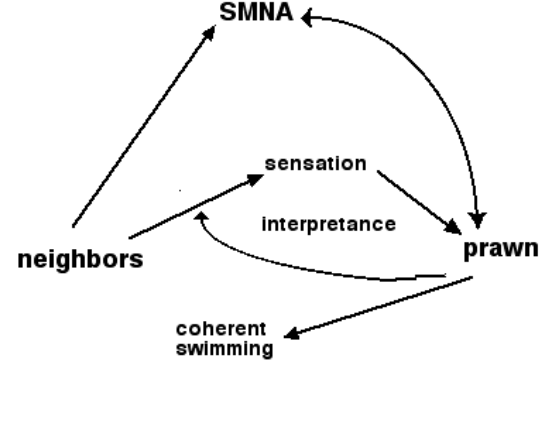
Figure 1. Peircean triadic diagram of semiosis. Neighbors are the object, short-term memory--now--anticipation (SMNA) the sign, the prawn is the system of interpretance [15]. Interpretance here labels the innermost cycle, within the prawn. Arrows indicate direction of information flow. Meaning emerges as coherent